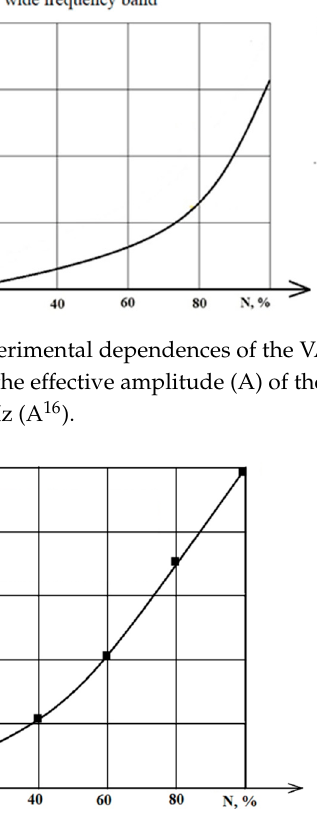
Figure 4. Experimental dependence of the performance (P) on the power output (N) of the laser